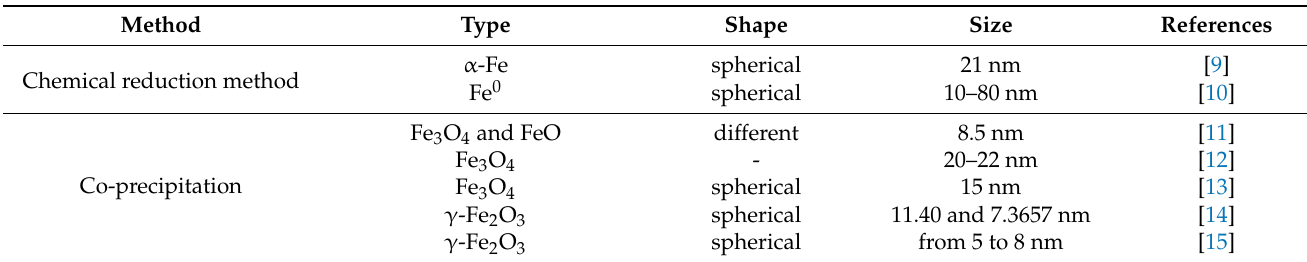
Table 1. Some typical synthesis methods for iron nanoparticles.